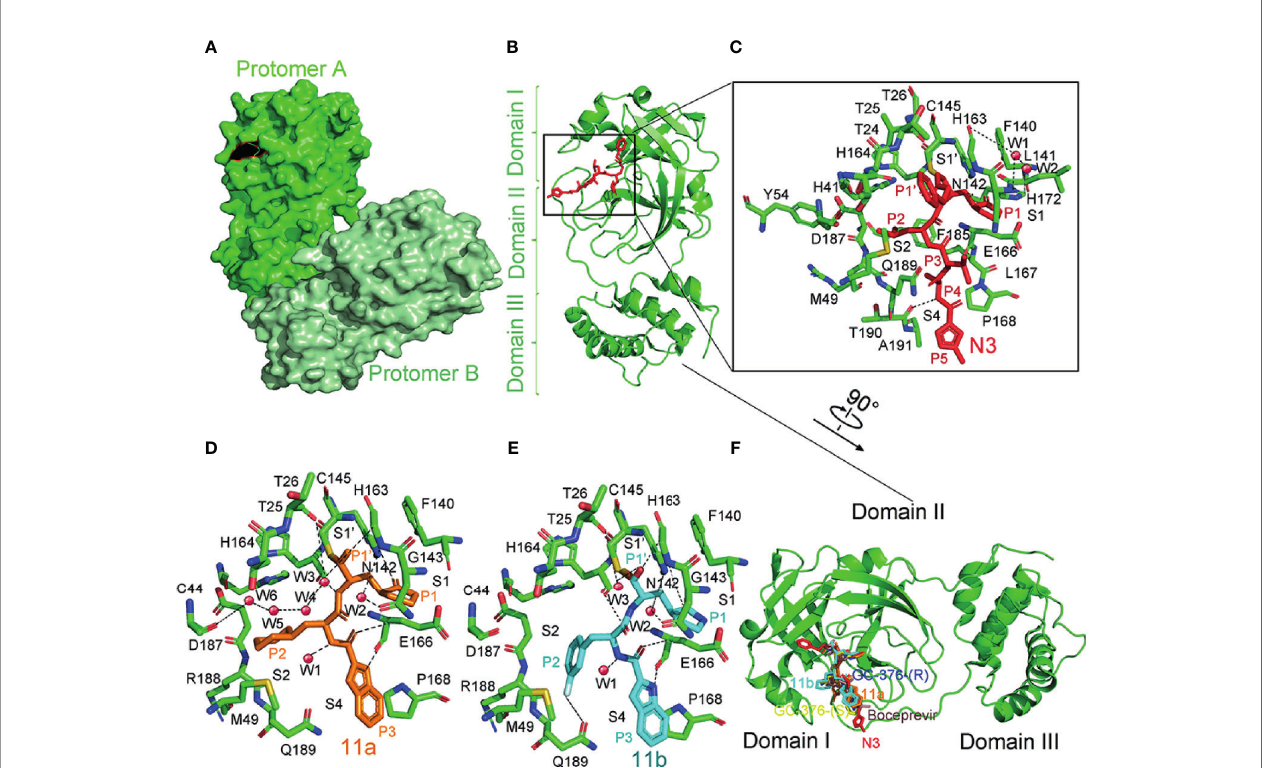
FIGURE 9 | The crystal structure of SARS-COV-2 virus Mpro in complex with inhibitors. (A) Surface representation of the homodimer of Mpro. Protomer A is in green, and protomer B is in pale green. (B) Cartoon representation of one protomer of the dimeric Mpro-inhibitor complex. The protomer is in green. N3 is in red sticks. (C) A zoomed view for the substrate-binding pocket. The key residues, which form the binding pocket, are shown as green sticks, the two waters, assigned as W1 and W2, are shown as red spheres. Four subsites, S1 ′ , S1, S2, and S4, are labeled. P1, P1 ′ , P2, P3, P4, and P5 sites of N3 are shown. Hydrogen bonds are indicated as dashed lines. (D) Close-up view of the 11a binding pocket. The residues involved in inhibitor binding are shown as green sticks. 11a and water molecules are shown as orange sticks and red spheres, respectively. Four subsites, S1 ′ , S1, S2, and S4, are labeled. P1, P1 ′ , P2, and P3 sites of 11a are indicated. Hydrogen bonds are indicated as dashed lines. (E) Close-up view of the 11b binding pocket. 11b and water molecules are shown as cyan sticks and red spheres, respectively. Four subsites, S1 ′ , S1, S2, and S4, are labeled. P1, P1 ′ , P2, and P3 sites of 11b are indicated. Hydrogen bonds are indicated as dashed lines. (F) Comparison of the inhibitor binding modes in SARS-CoV-2 Mpro. Two con fi gurations (S and R) of GC-376, 11a, 11b, N3, and Boceprevir are shown in yellow, blue, orange, cyan, red, and dirty violet, respectively. All structures are drawn by Pymol.